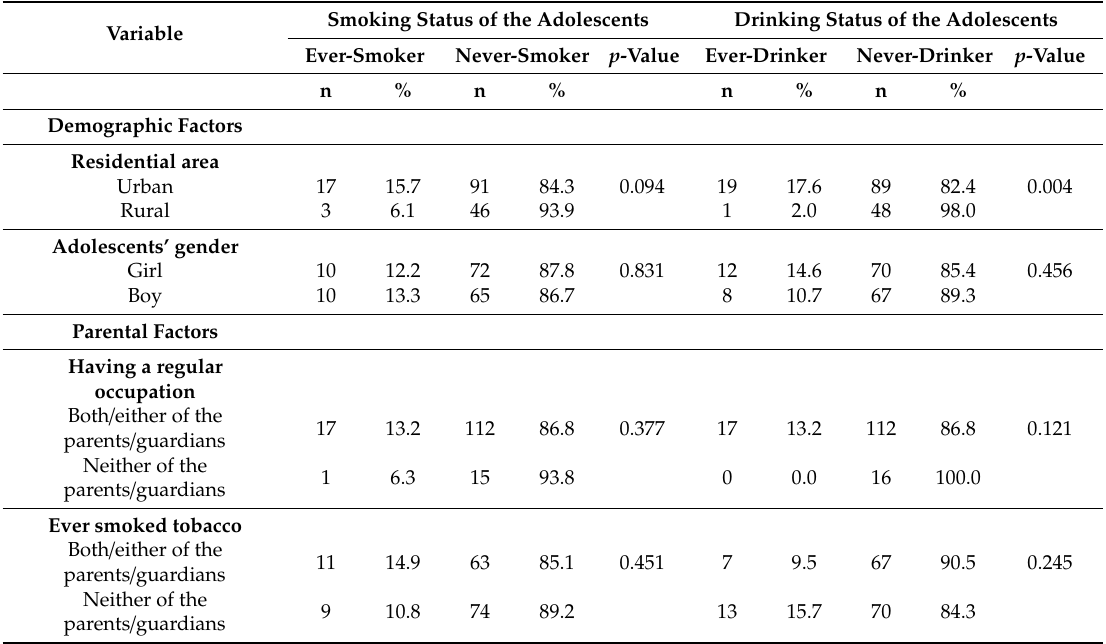
Table 3. Bivariate association between parental, sibling, and peer factors, and ever smoking and drinking among adolescents (n =